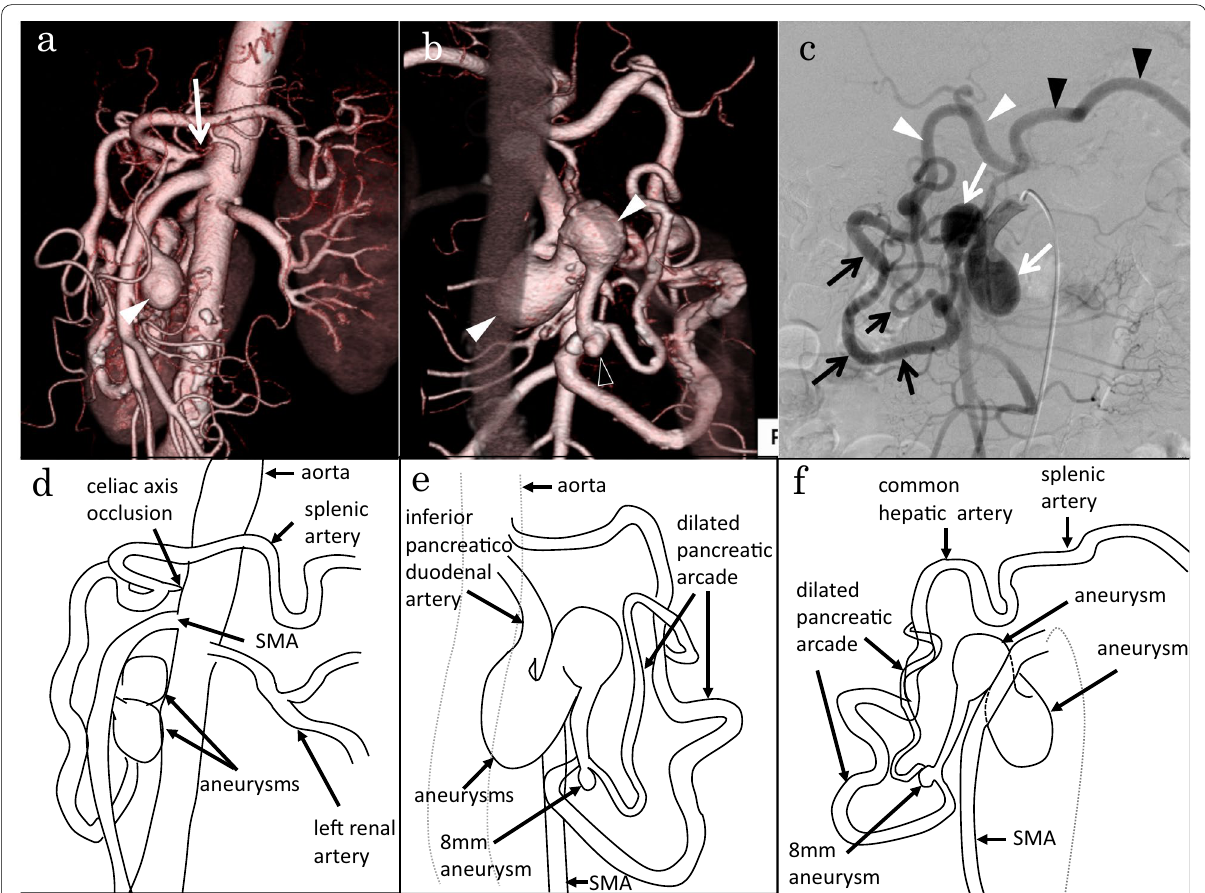
Fig. 1 Images before bypass surgery from Case 1. a , b Three-dimensional computed tomogram showing celiac axis occlusion (white arrow) and a markedly dilated pancreatic arcade with two large fusiform inferior pancreaticoduodenal artery aneurysms (PDAAs) (white arrowheads) a small PDAA (transparent arrowhead). c Angiogram of the superior mesenteric artery showing a markedly dilated pancreatic arcade (black arrows) with two large fusiform inferior PDAAs (white arrows) and retrograde flow of the gastroduodenal artery and common hepatic artery via the pancreatic arcade (white arrowheads) and retrograde flow of splenic artery via the common hepatic artery (black arrowheads). d The schematic diagram of a . e The schematic diagram of b . f The schematic diagram of